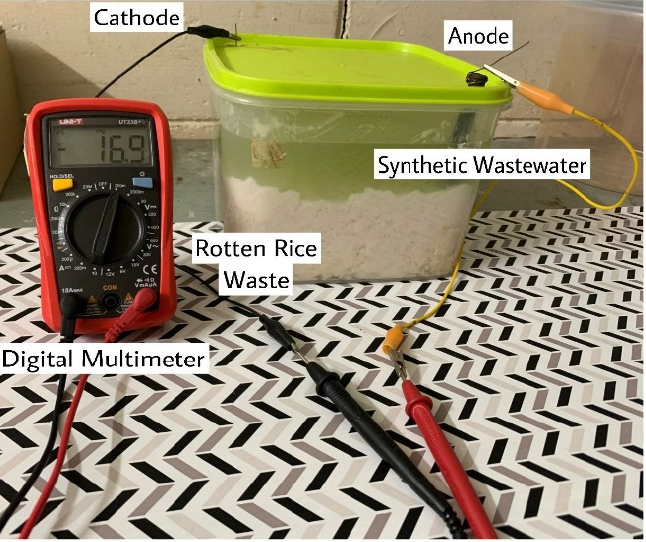
Figure 1. MFC set-up for hydroquinone